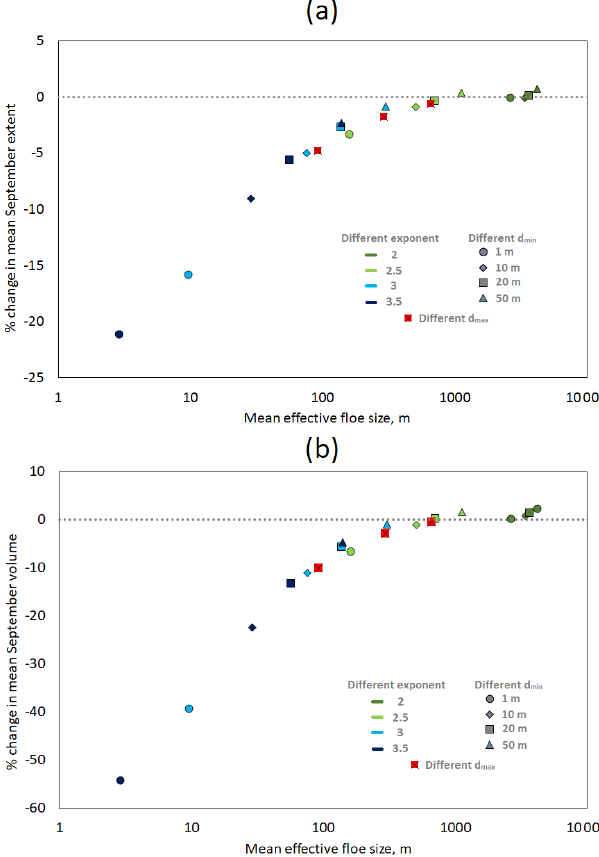
and volume (b) from 2007 to 2016 respectively, plotted against mean l eff for simulations with different selections of parameters rel- ative to ref. The mean l eff is taken as the equally weighted average across all grid cells where the sea ice concentration exceeds 15%. The colour of the marker indicates the value of the α , the shape in- dicates the value of d min , and the three experiments using standard parameters but different d max (1000, 10000, and 50000m) are in- dicated by a crossed red square. The parameters are selected to be representative of a parameter space for the WIPoFSD that has been constrained by observations. Model response ranges from small in- creases in the sea ice extent and volume to reductions of over 20% and 50% respectively. The mean l eff is shown to be a good predictor of the response of the sea ice extent and